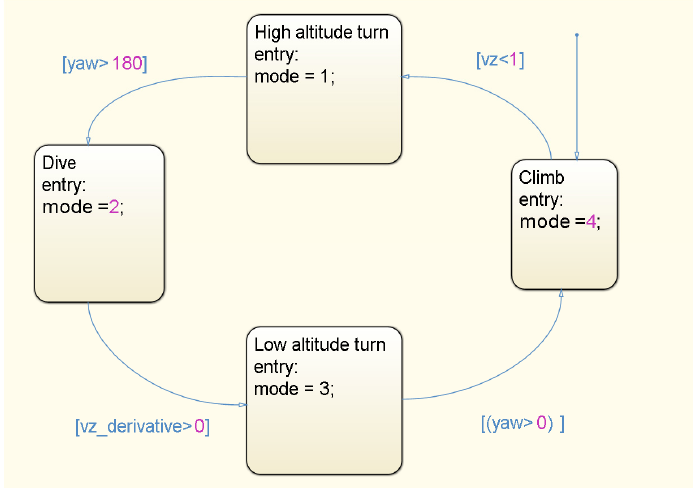
Figure 15. Snapshot of the Stateflow chart.